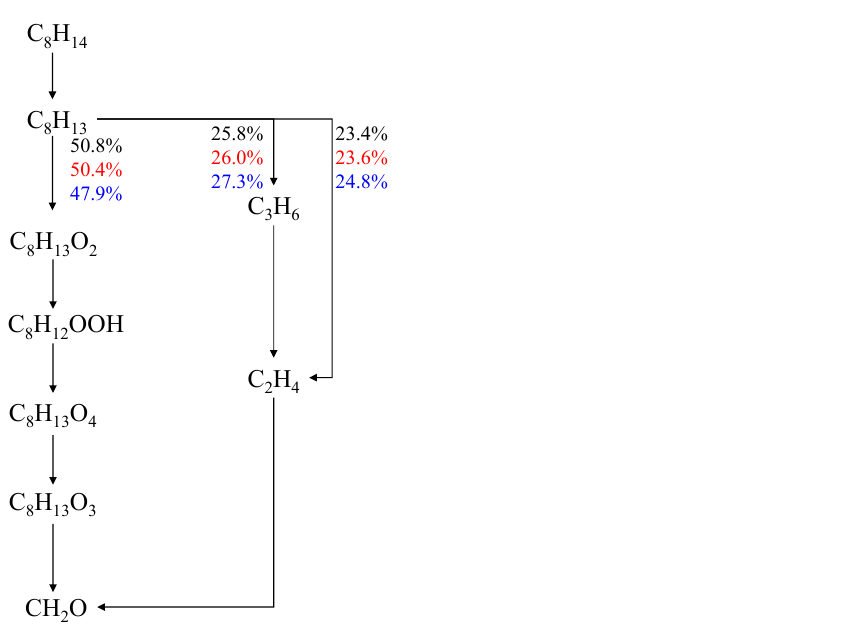
Figure 8. Effects of equivalence ratio on the chemical reaction path of gasoline. (T = 800 K; P = 20 bar; black: Φ = 0.8; red: Φ = 1; blue: Φ = 1.2).